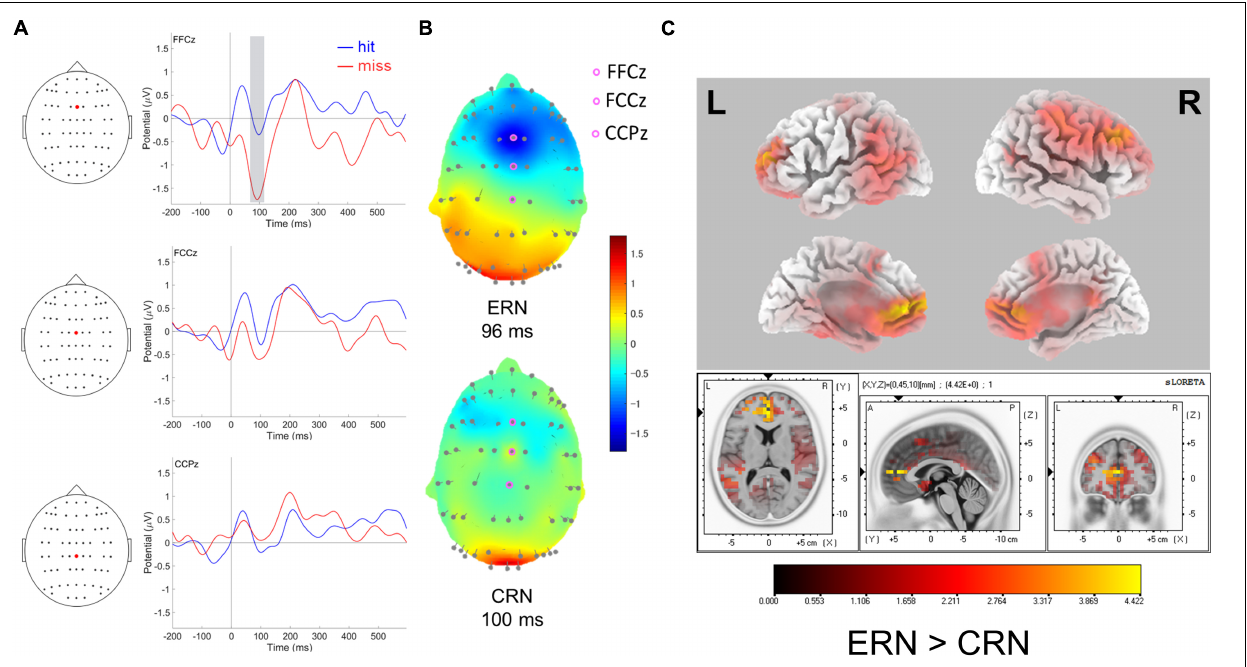
FIGURE 2 | (A) Response-locked ERPs following hit and miss shots at FFCz, FCCz, and CCPz. The gray-shaded square in FFCz represents the time-range used for sLORETA source localization (left). (B) Topographic maps of ERP amplitudes for miss (top: ERN) and hit (bottom: CRN) response-locked negativities, at 96 and 100 ms, respectively. (C) Standardized low-resolution electromagnetic tomography (sLORETA) for response-locked ERPs. The colored voxels represent statically higher values for miss response than for hit response at the peak of ERN (96 ms).